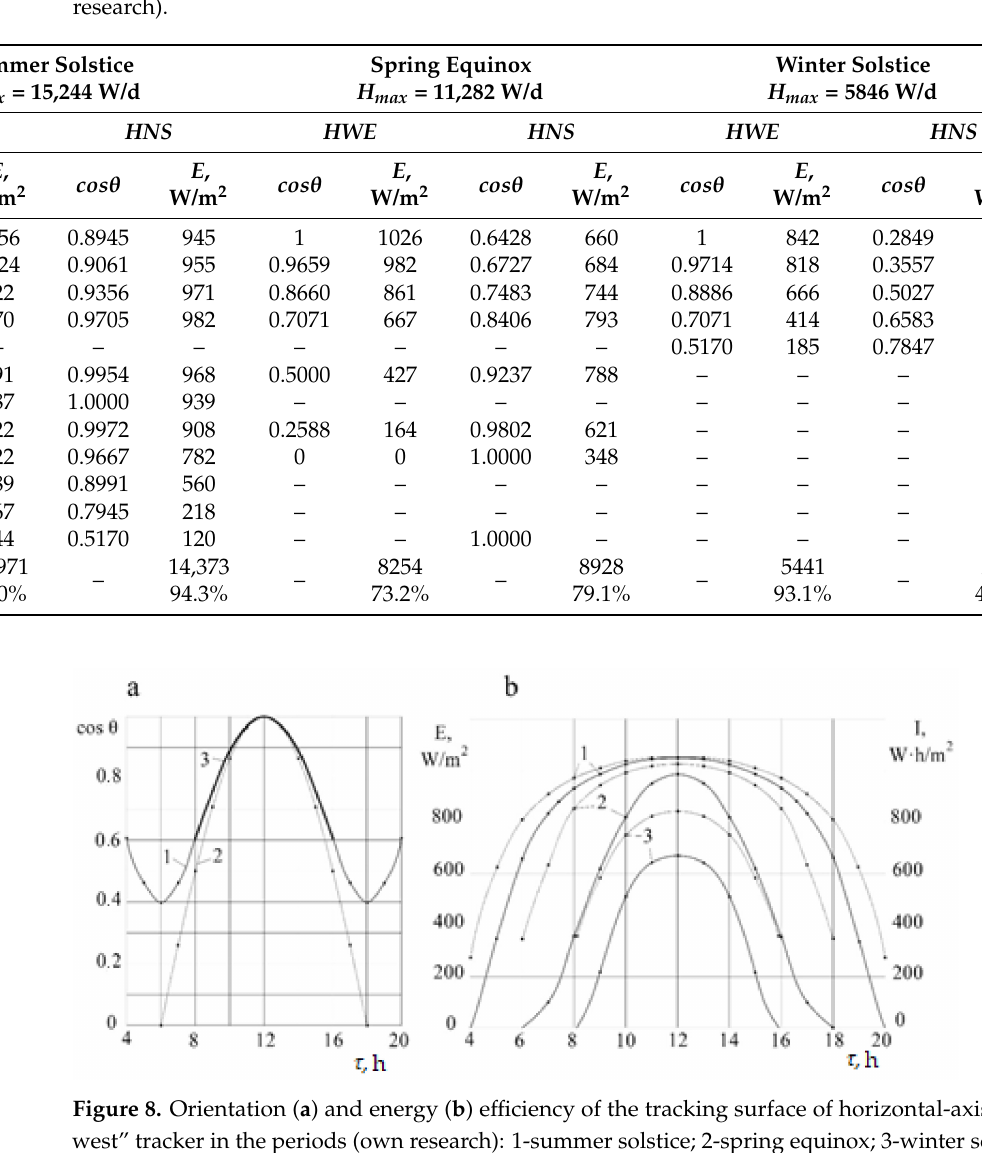
Table 5. Orientation and exposure efficiency of the tracking surface of horizontal axis trackers (own research).